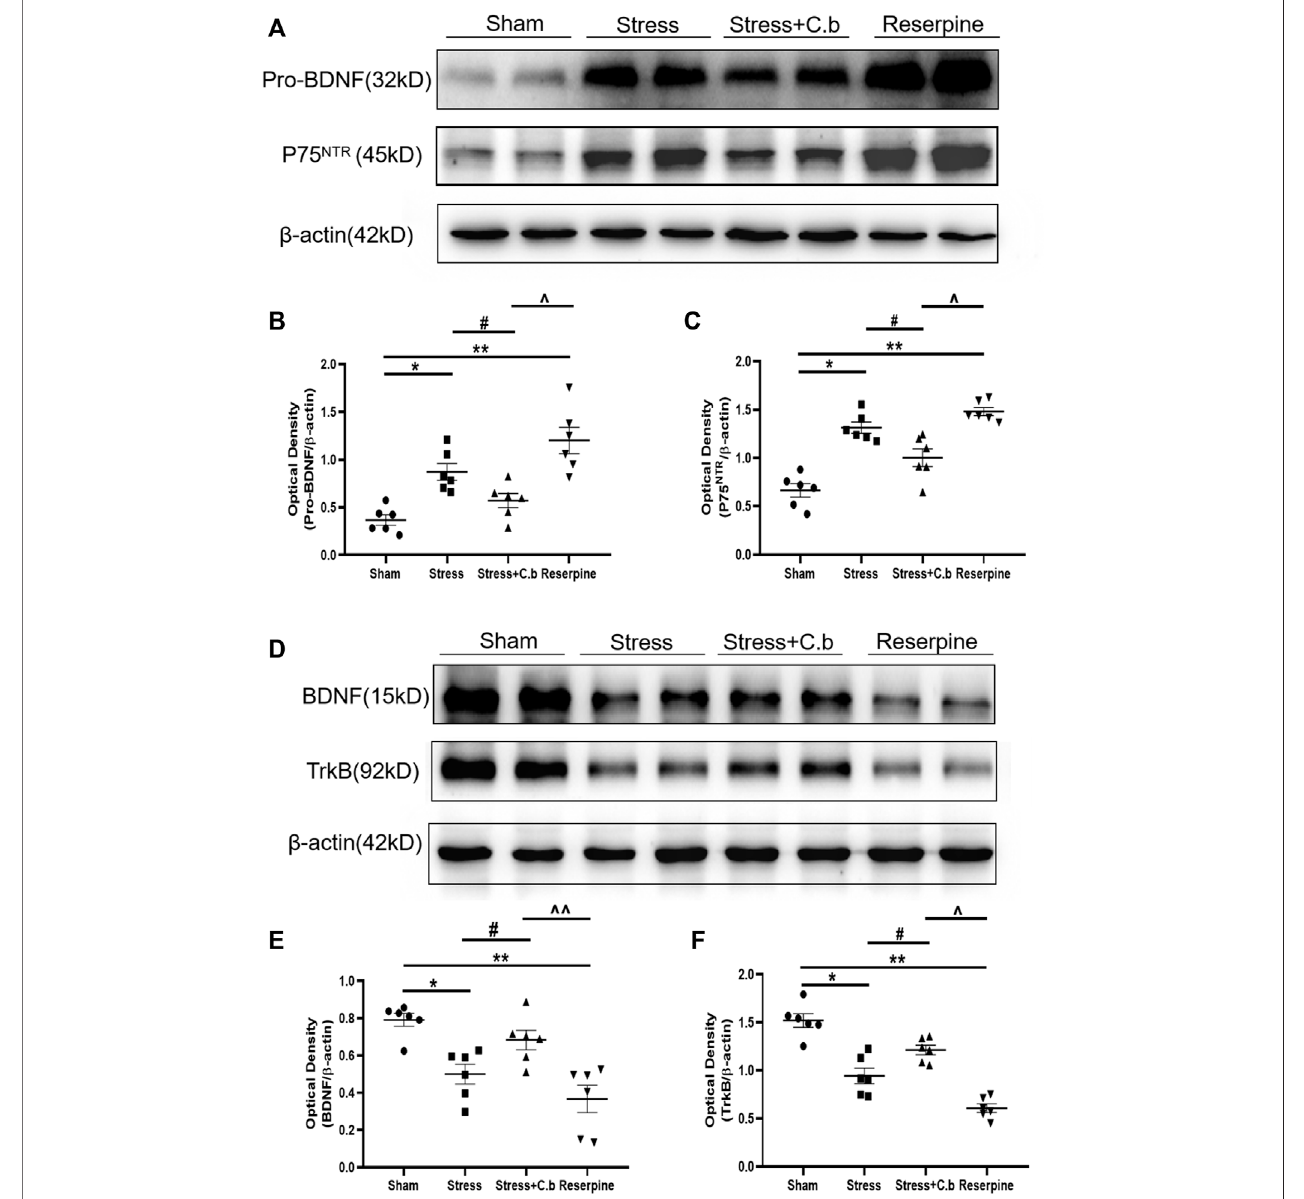
FIGURE 6 | Effects of C. butyricum RH2 on the expression of proBDNF, P75 NTR , BDNF and TrkB in the hippocampus of CFSS rats. (A – C) proBDNF and P75 NTR wereupregulatedafter CFSSbut theincreasewaspartiallyreversedbyC.butyricum RH2. (D – F) BDNF andTrkBweredownregulatedafter CFSSbutthedecrease was partially reversed by C. butyricum RH2. * p < 0.05, ** p < 0.01 versus sham group; # p < 0.05, ## p < 0.01 versus stress group; ^ p < 0.05, ^^ p < 0.01 versus stress + C. butyricum group.